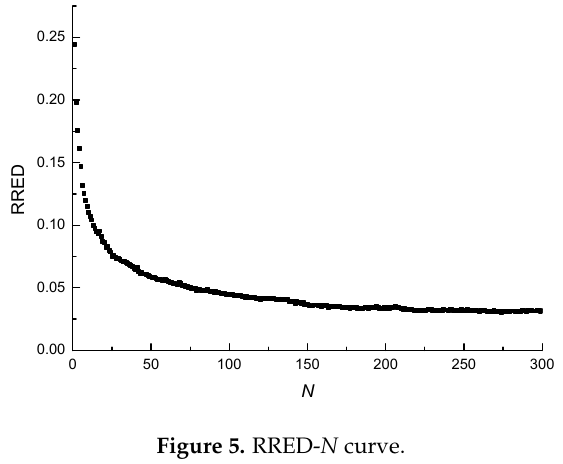
Figure 5. RRED- N curve.